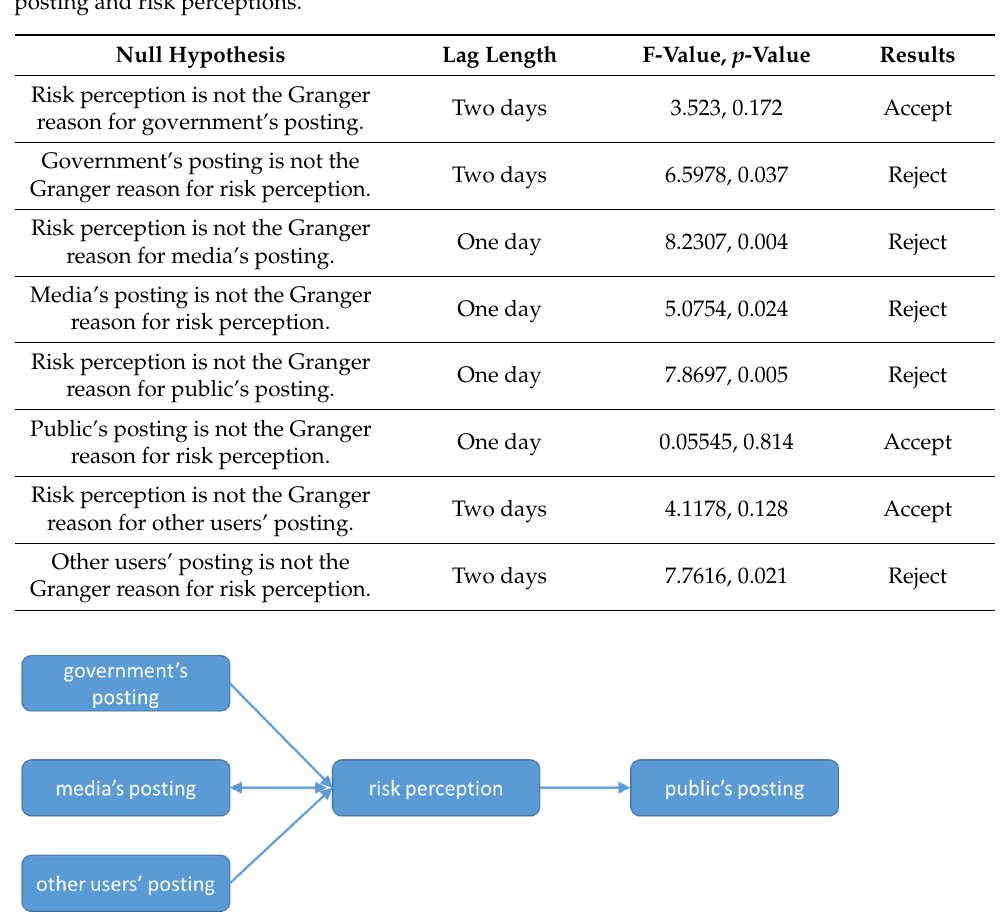
Table 4. Results of Granger causality tests between government, media, public, and other users’ posting and risk perceptions.